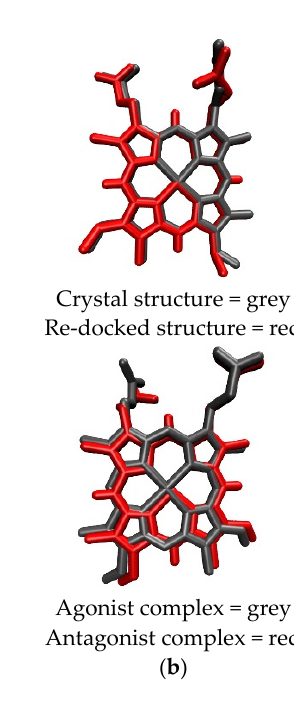
Figure 3. Overlay structures of Heme ( a ) and CoPP ( b ) in re-docking and docking simulation. Table 1. The binding energy and RMSD value of CoPP and Heme in molecular docking. Protoporphyrin Ligand